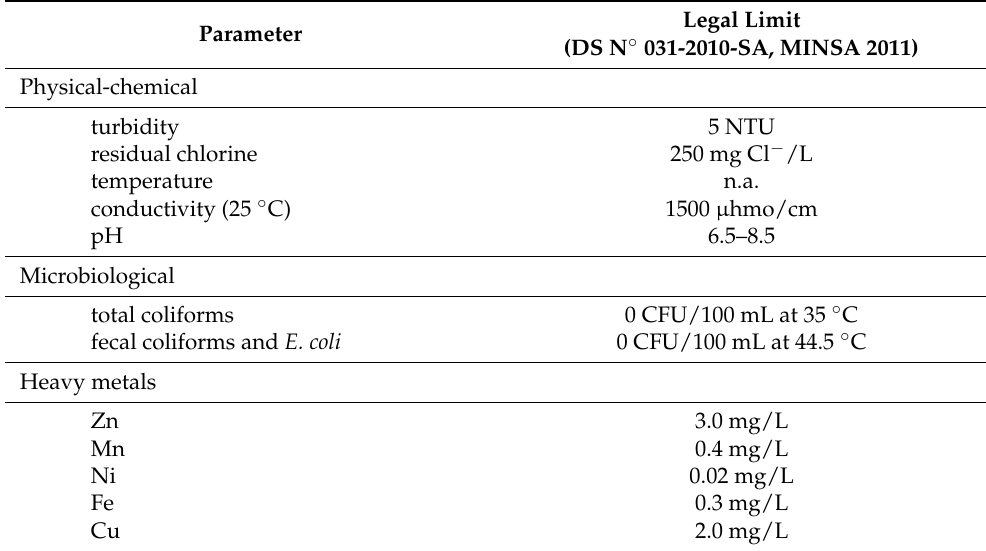
Table 2. Legal limits allowed in water used for human consumption according to the Peruvian reg- ulation (DS N° 031-2010-SA) [25].